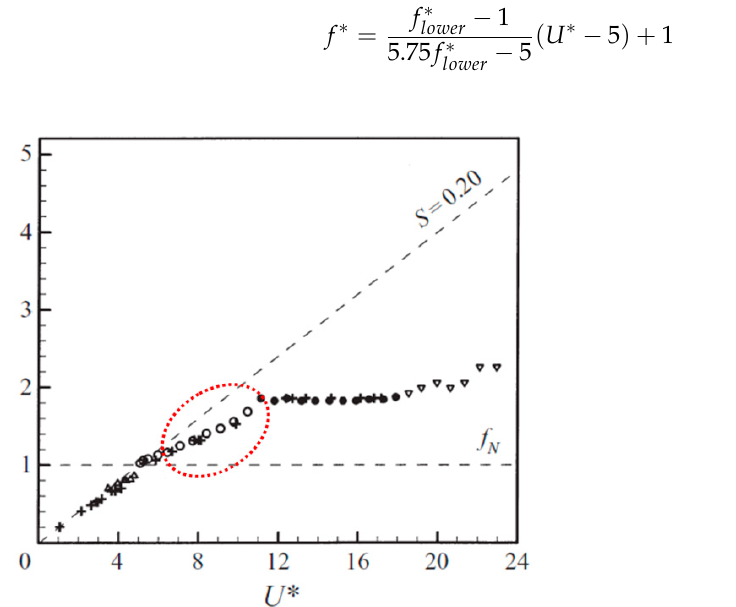
Figure 4. Frequency response of vortex-induced vibration of cylinder having distinct upper branch ( m* = 1.2, ζ = 0.005) [14].